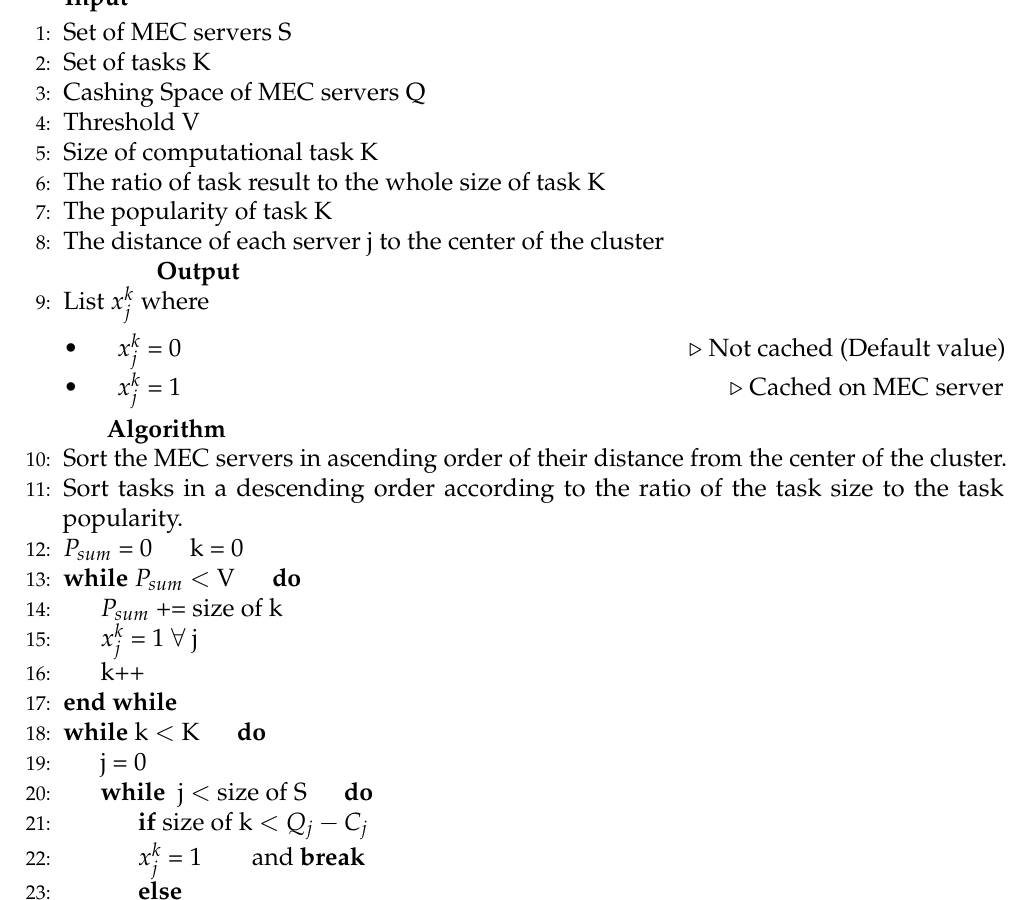
Algorithm 1 The proposed algorithm for Cluster-based Multi-user Multi-Server Caching mechanism in B5G/6G